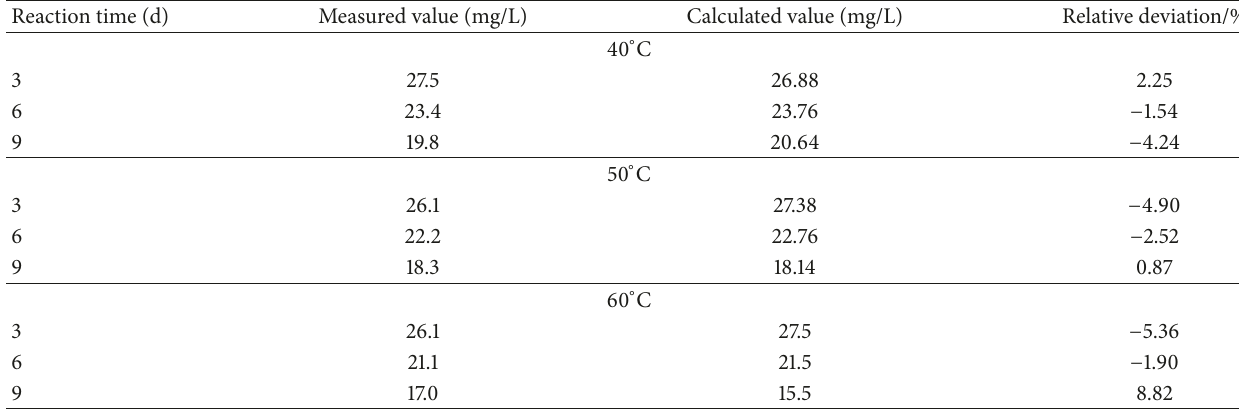
Table 3: Relative deviation between experimental and calculated VSS concentrations.